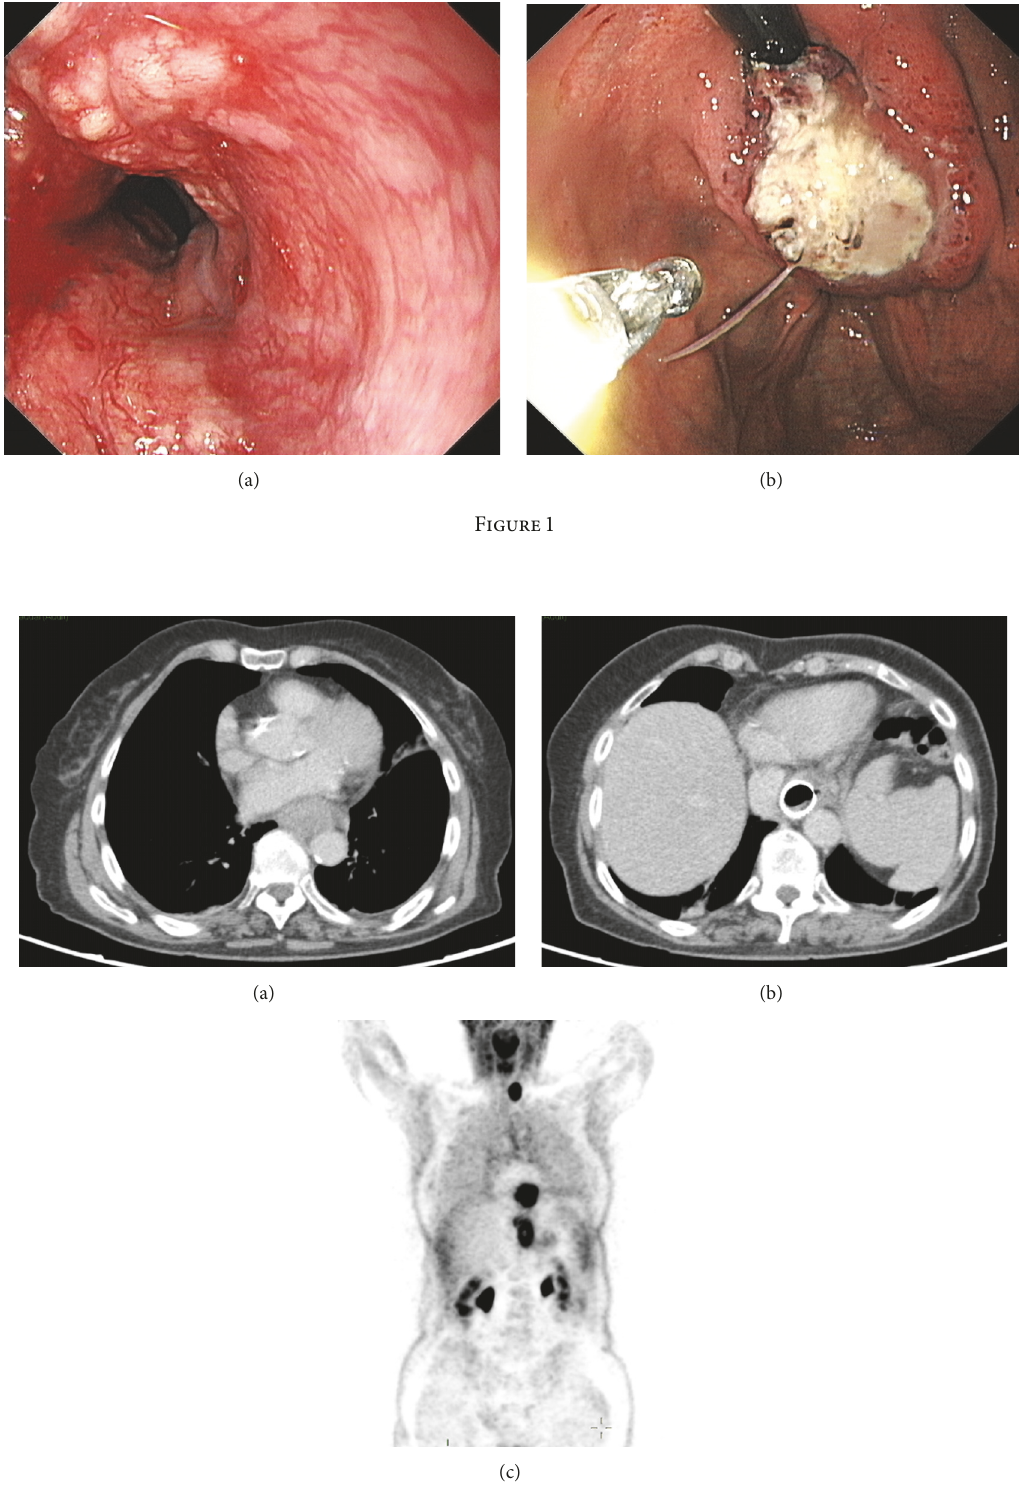
Figure 2: Axial contrast enhanced CT at the level of the mid-oesophagus (a) demonstrates a circumferential soft tissue oesophageal mass with increased metabolic activity (SUVmax 15.0) on the PET component of the study (c). Axial contrast enhanced CT at the level of the gastroesophageal junction (b) demonstrates soft tissue thickening surrounding the gastric stent in situ. The PET component of the study (c) at this level shows increased FDG avidity (SUVmax 14.2) consistent with a second tumour. Incidental note of a FDG avid left thyroid